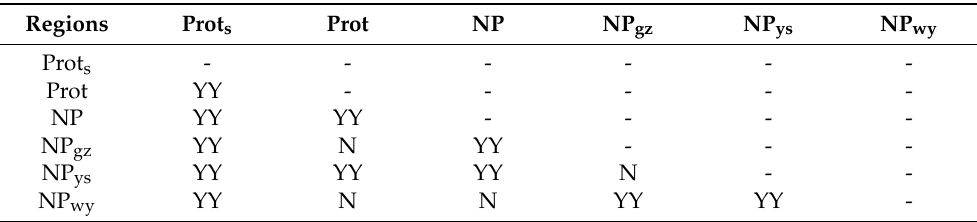
Figure 6. The percentage of negative abrupt change area each year from 1986 to 2020. Prot s : Wuyishan Nature Reserve; Prot: non-nature reserve within Wuyishan National Park; NP: non-protected areas; NP gz : non-protected areas in Guangze County; NP ys : non-protected areas in Yanshan County; NP wy : non-protected areas in Wuyishan City. Table 6. Significance test of negative abrupt change area proportions among different regions during